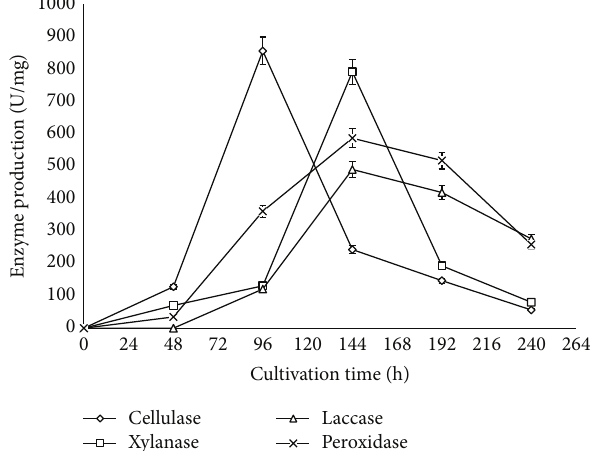
Figure 2: Effect of cultivation time on production of lignocellu- lolytic enzymes (error bars represent mean values and standard deviation of triplicate